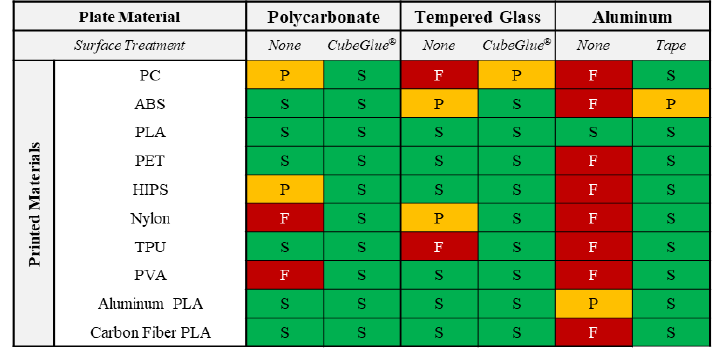
Figure 24. Stoplight chart to compare printing test success.